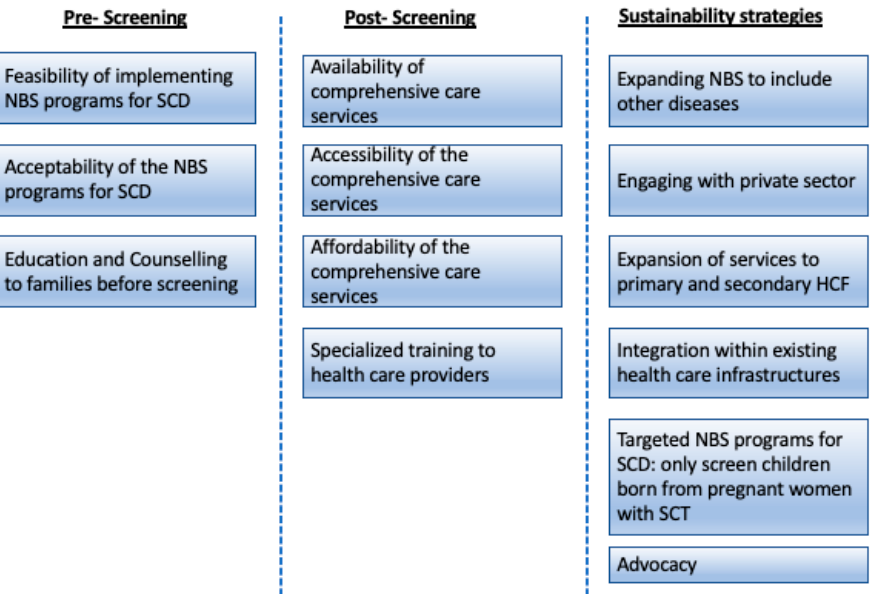
Figure 3. Summary of the three categories of the analysis (pre-screening, post-screening and sustainability strategies) and the main themes identified in each of the categories. HCF- Health Care Facilities; SCT- Sickle Cell Trait.